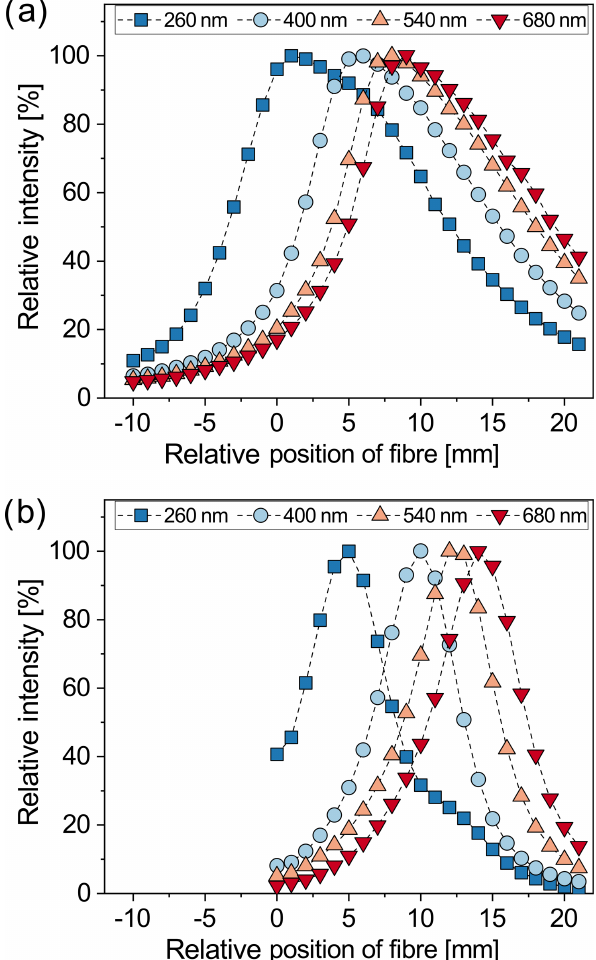
Figure B2. Variation in the relative intensity of selected spectral regions as a result of the chromatic aberration as a function of the relative position of the fibre. Panel (a) shows results for a coupling into a 800µm fibre, panel (b) is the same as (a) but for a 200µm fibre. For both plots, the increasing selectivity towards the UV due to the non-linear increase in the refractive index is visible. For the smaller fibre diameter the chromatic-aberration filter becomes even more